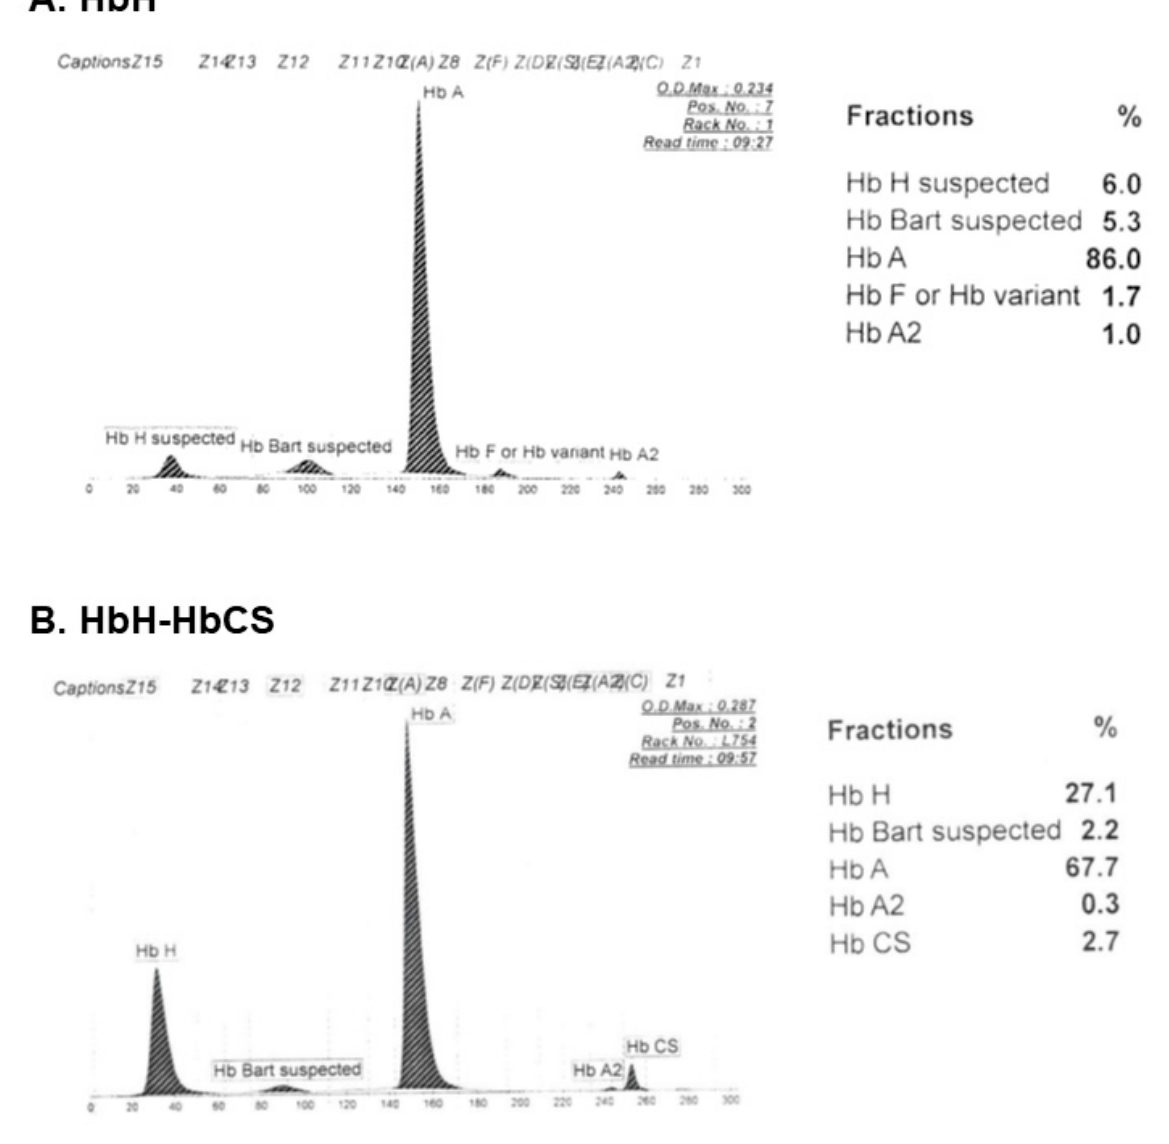
Figure 2. Hemoglobin analysis of patients with HbH ( A ) and HbH-HbCS ( B ) using capillary zone electrophoresis.